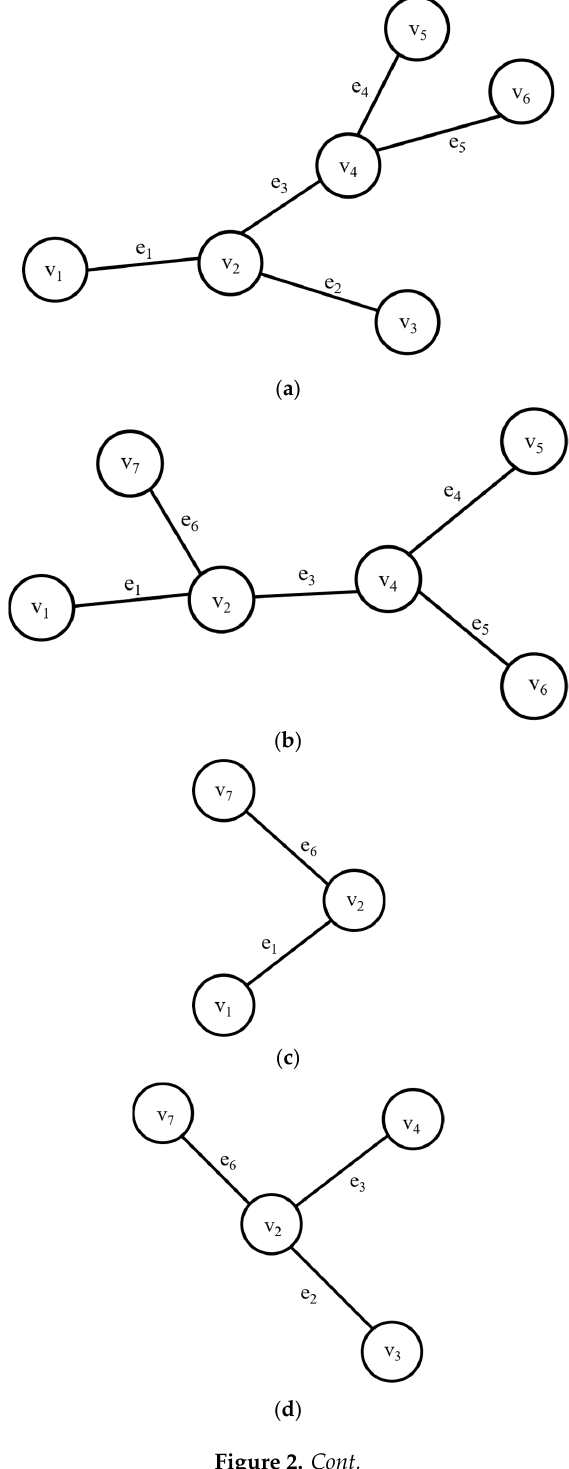
Figure 3b using the information of the edges stored in Figure 3a. FP-trees were created to extract the subgraphs used by past queries. Since e 1 and e 3 occurred most frequently, the FP-tree was created on the depth first search (DFS) proposed in